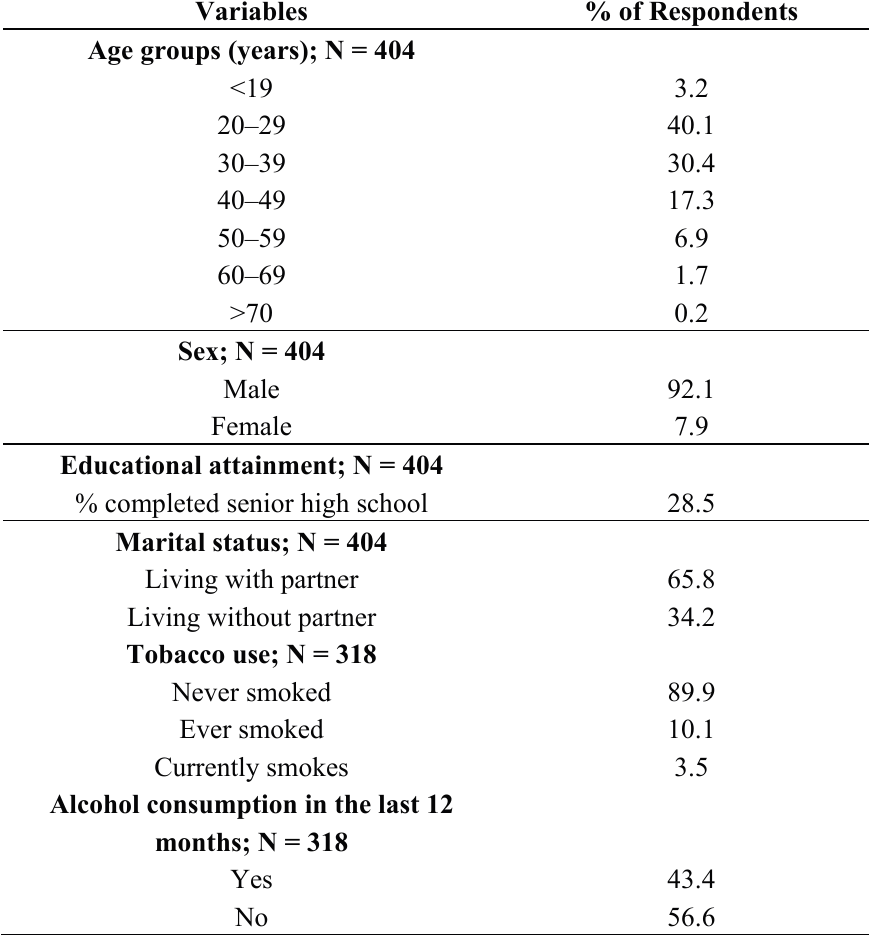
Table 1. Socio-demographic characteristics of the study